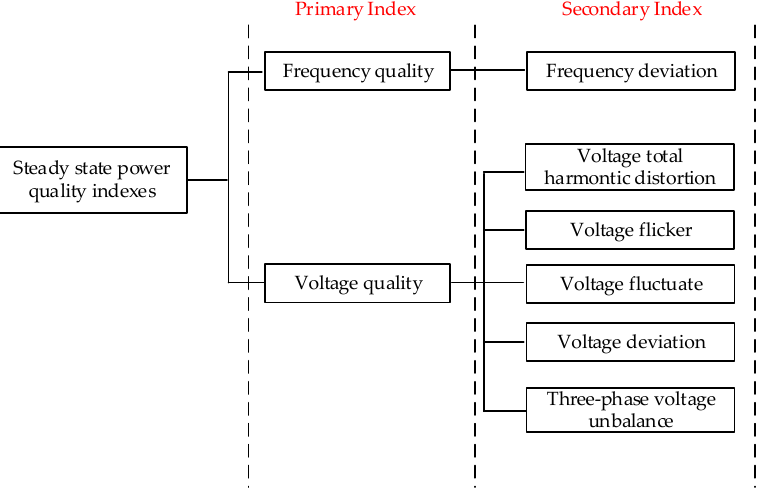
Figure 1. Steady-state power quality index system.